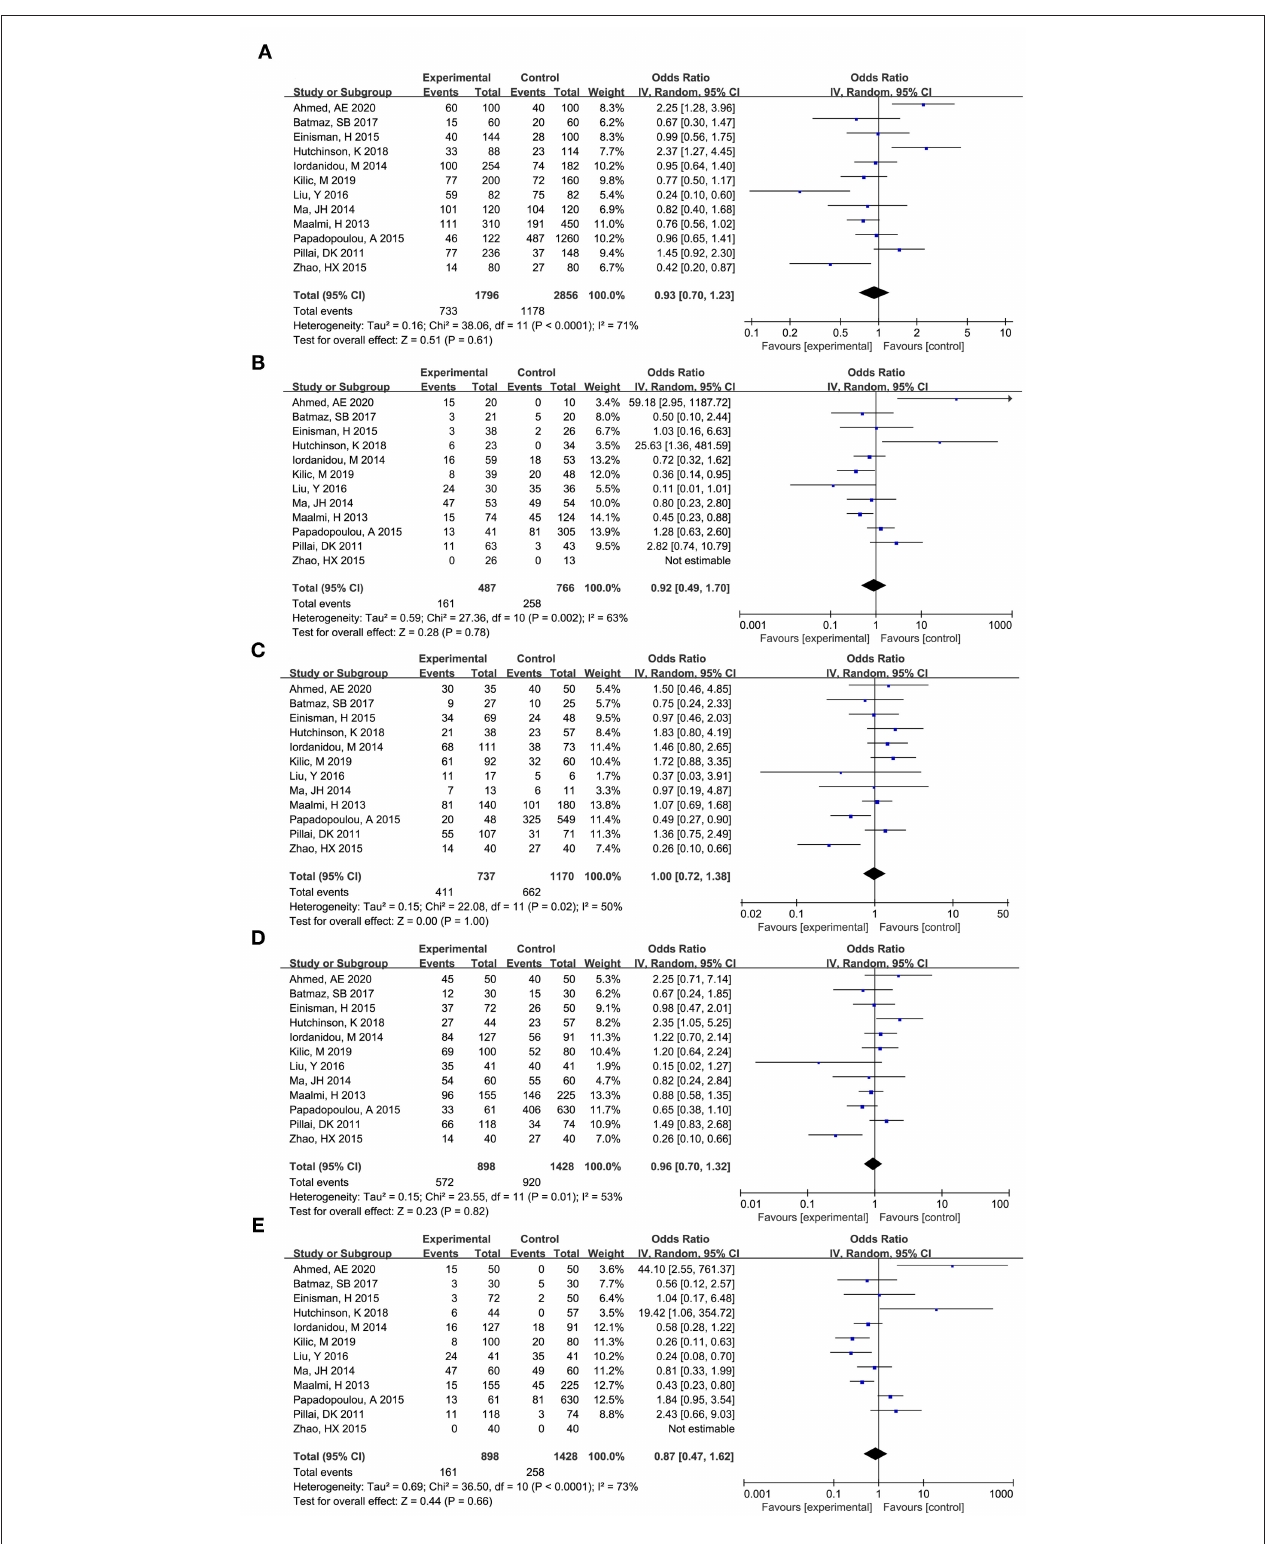
FIGURE 3 | Forest plot for meta-analyzing the association between Vitamin D receptor TaqI (rs731236) polymorphisms and childhood asthma. (A) additive model: t vs. T; (B) co dominant model: tt vs. TT; (C) co dominant model: Tt vs. TT; (D) dominant model: tt + Tt vs. TT; (E) recessive model: tt vs. TT + Tt.